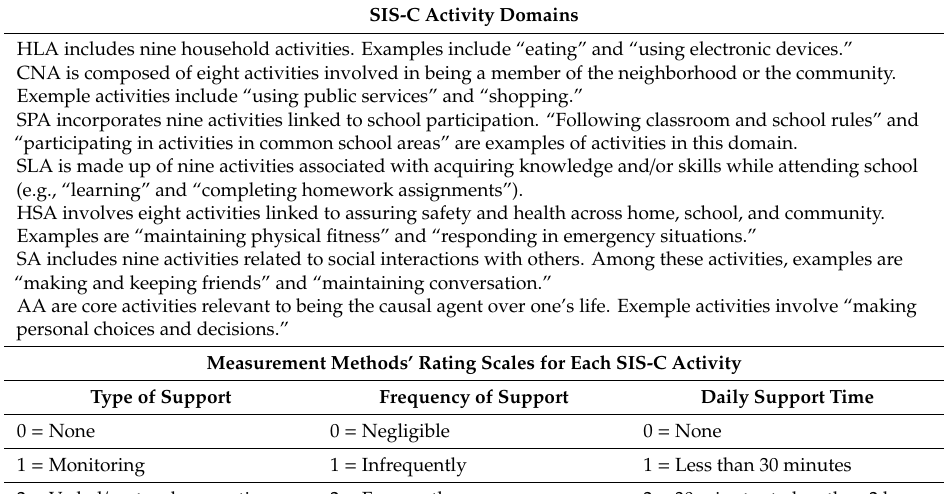
Table 1. Supports Intensity Scale–Children’s Version (SIS-C) domains’ descriptions and measurement methods for the ‘Support Needs Scale’